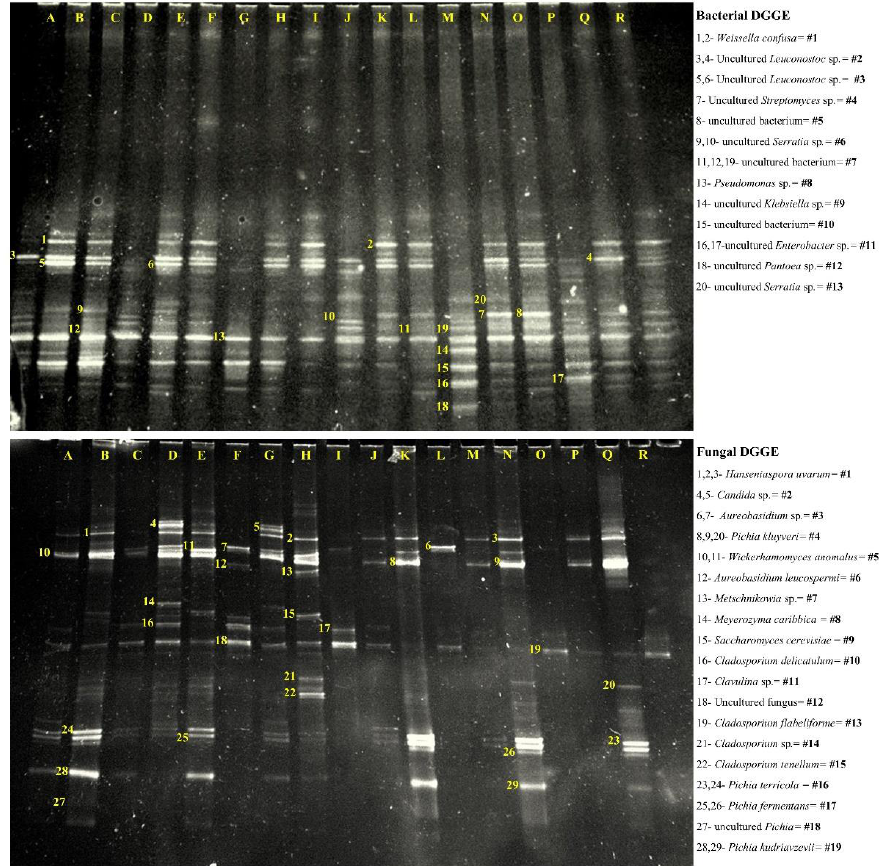
Figure 1. DGGE microbial profile of bacteria and fungi at different times and altitudes. The numbers over the bands correspond to the identified microorganism on the right. The upper image corresponds to the bacterial profile, and the lower image corresponds to the fungal profile. N process: 800 (A, B, C), 1200 (D, E, F), and 1400 m (G, H, I), and PN process: 800 (J, K, L), 1200 (M, N, O), and 1400 m (P, Q, R). T0 (A, D, G, J, M, and P), T48 (B, E, H, K, N, and Q), and TF (C, F, I, L, O, and R).